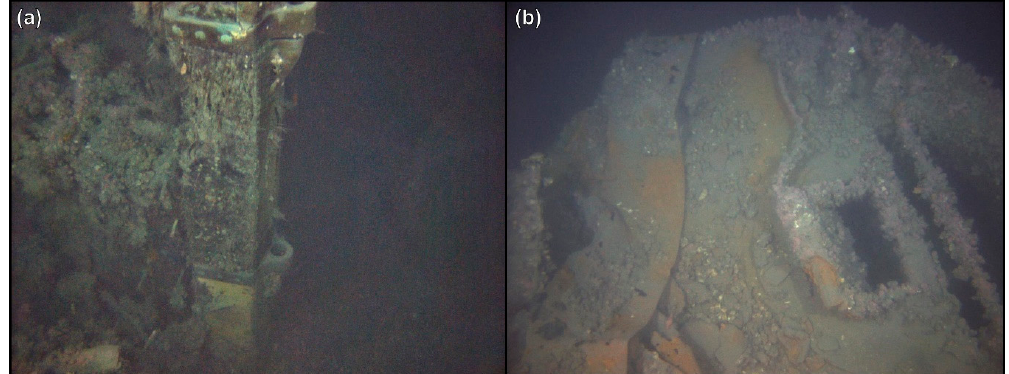
Figure 10. Camera stills from the 2016 remotely operated vehicle (ROV) survey. Panel ( a ) shows the rudder post with possible traces of shipworm attack, whereas panel ( b ) shows the top of a boiler with rust patches.